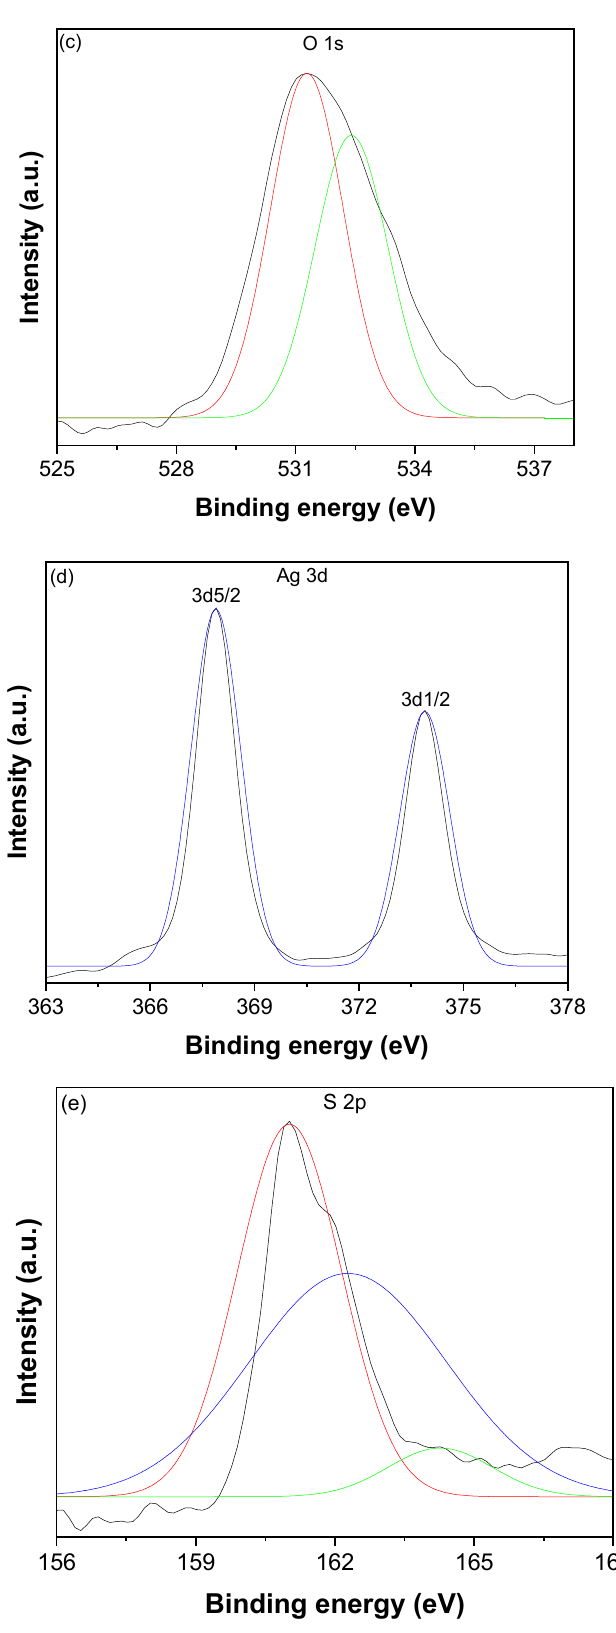
Figure 6. ( a ) XPS survey spectrum of CNTs-Ag 2 S. ( b ) High-resolution spectrum of C1s. ( c ) High-resolution spectrum of O1s. ( d ) High-resolution spectrum of Ag3d. ( e ) High-resolution spectrum of S2p.